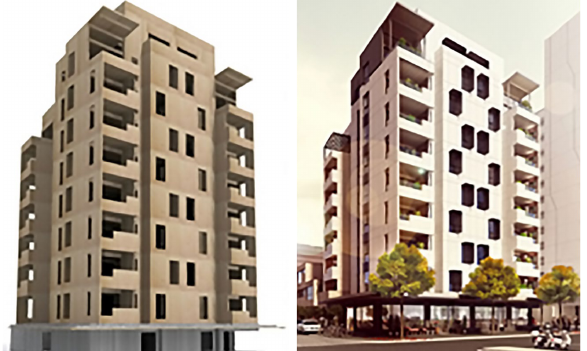
Figure 6. Forte Development , Melbourne, Australia (KLH UK, 2012)